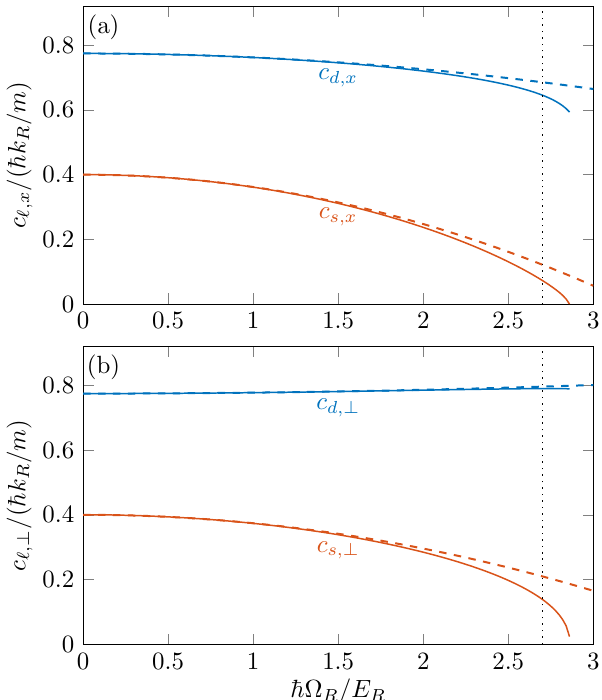
. The results for R = 2.70 E R R